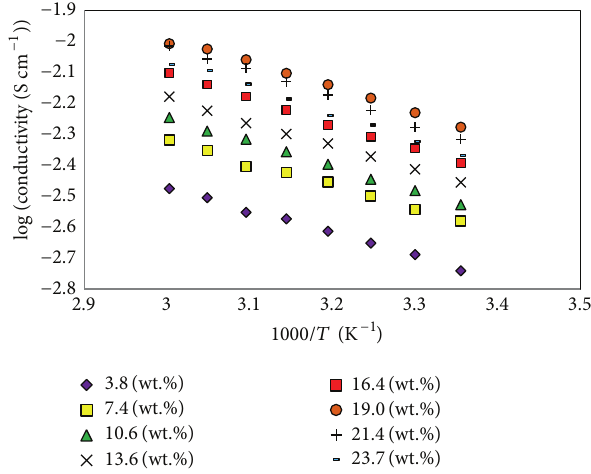
Figure 2: Temperature dependence of conductivity for phthaloyl- chitosan doped with different wt.% of Pr 4 NI